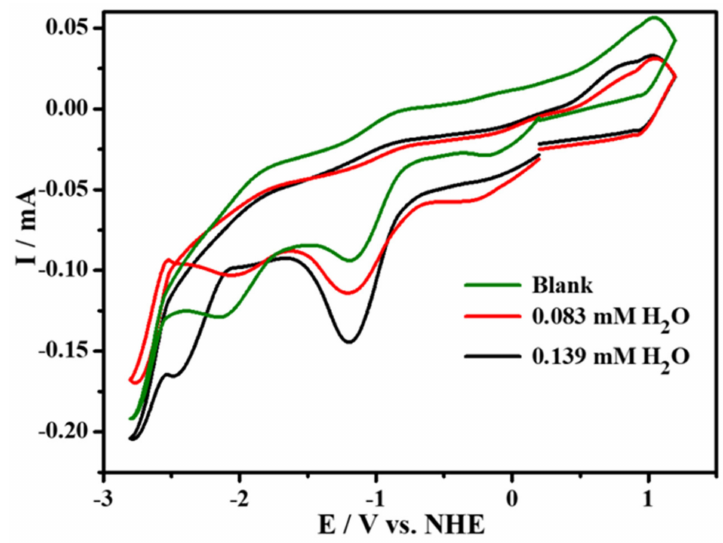
Figure 5. Cyclic voltammograms of the complex 1 containing the H 2 O system at different con- centrations in the CO 2 atmosphere. Scan rate: 100 mV s − 1 . Working electrode: glassy carbon. Counter-electrode: Pt wire. Reference electrode: Ag/AgCl.